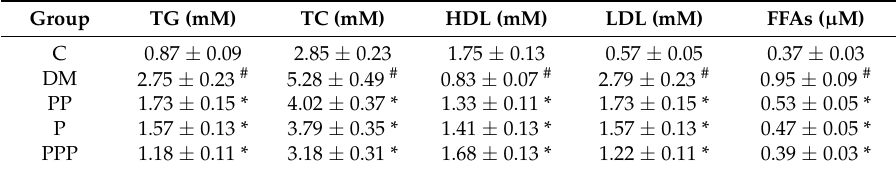
Table 2. The effect on serum lipid levels.